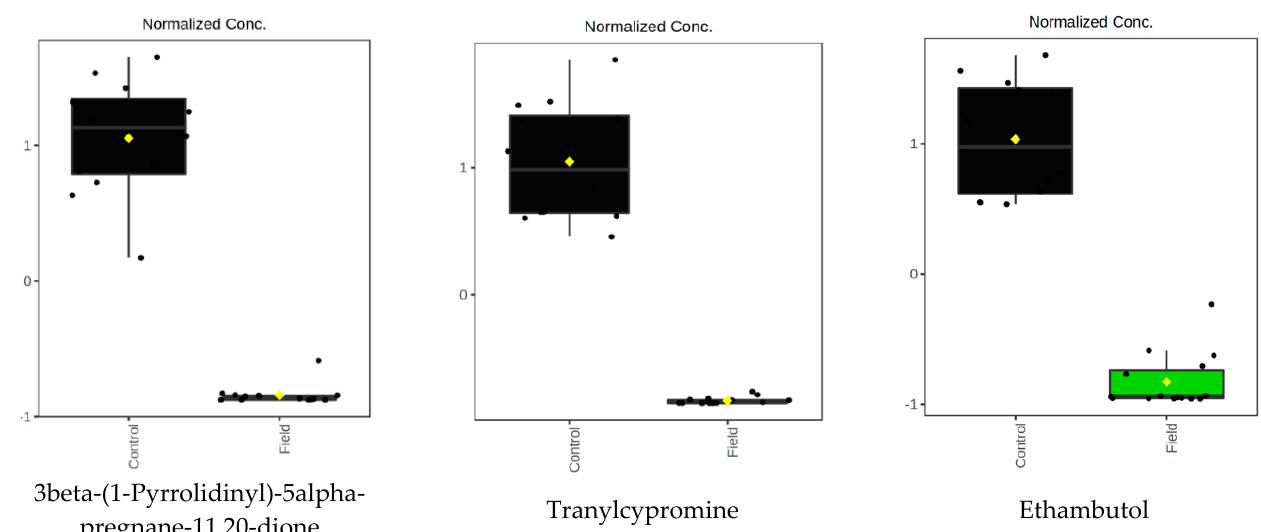
Figure 6. The normalized peak intensity of proposed metabolites as the metabolite biomarkers in field soil (contaminated soil); raw peak intensity of LC–MS was normalized by statistical analysis using data filter (relative standard deviation, (RSD)), normalization by sum, and data scaling (Pareto scaling).